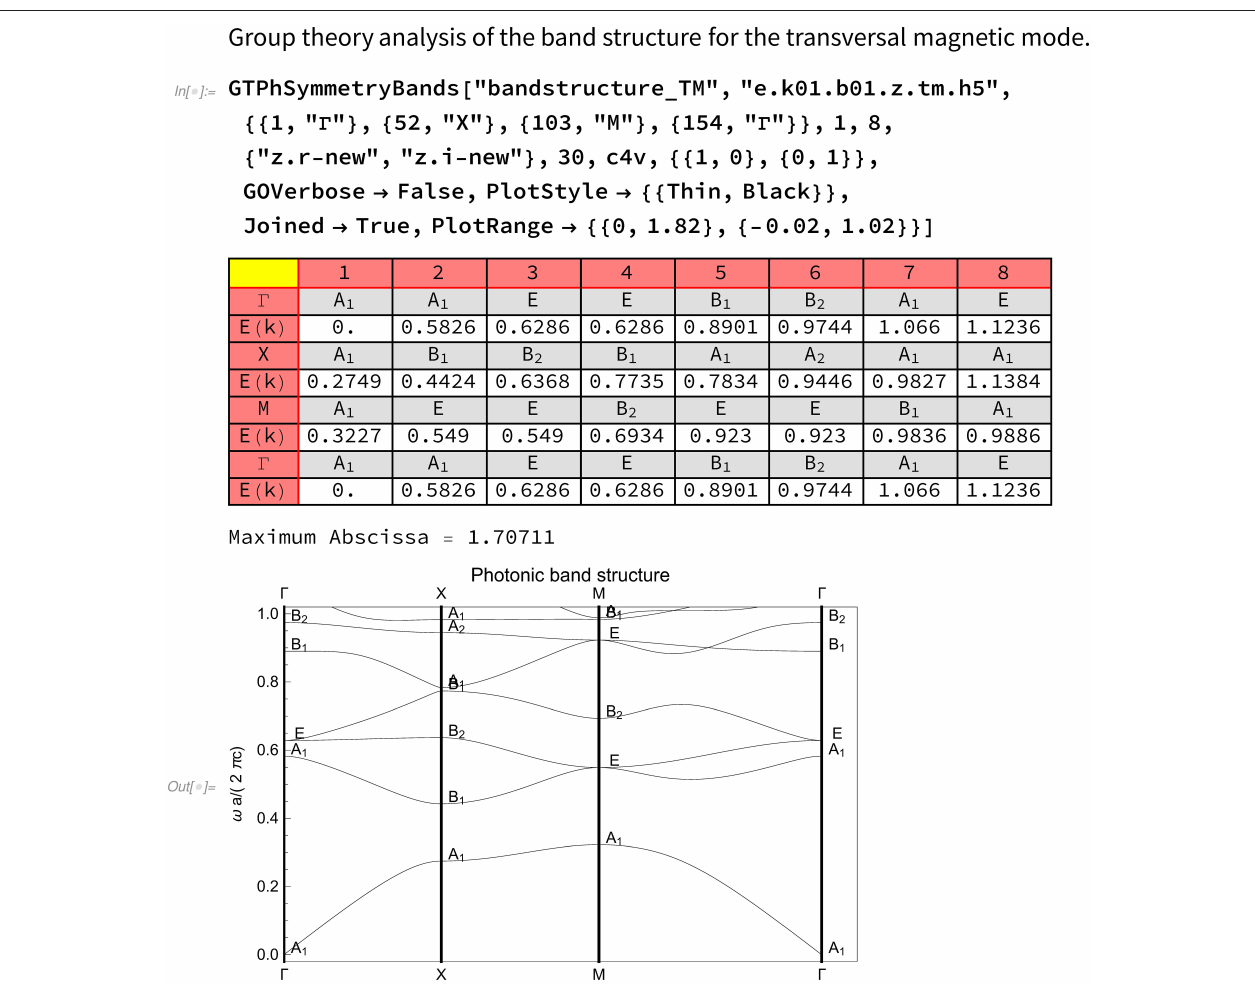
FIGURE 8 | Photonic band structure for a two-dimensional square lattice of alumina rods in air calculated using MPB and analyzed with GTPack.